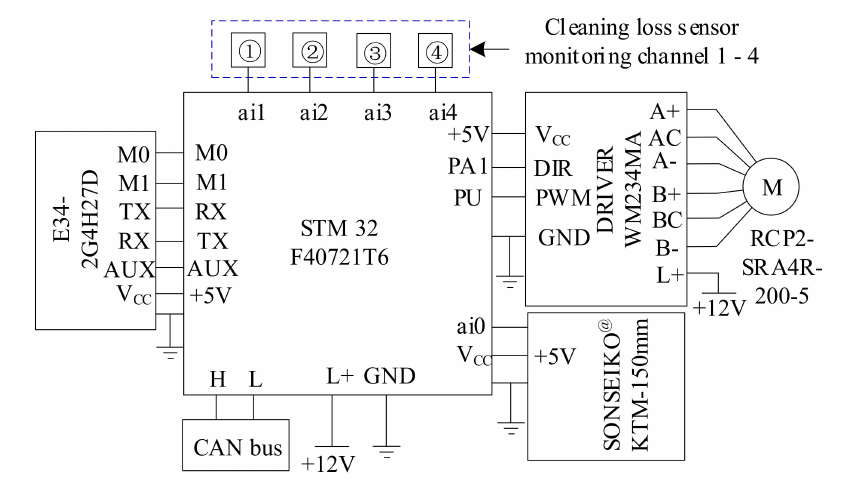
Figure 7. Wiring diagram of the grey fuzzy controller.